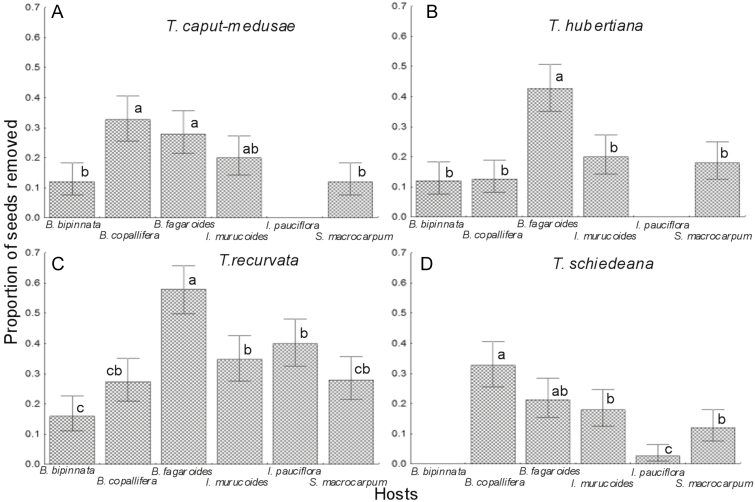
Proportion of seeds depredated in four species of epiphytes placed on six host tree species of the tropical dry forest of San Andrés de la Cal, Tepoztlán, in Morelos, Mexico. Different letters denote significant differences in seed depredation among host species. The lines of dispersion are binomial 95 % confidence intervals.